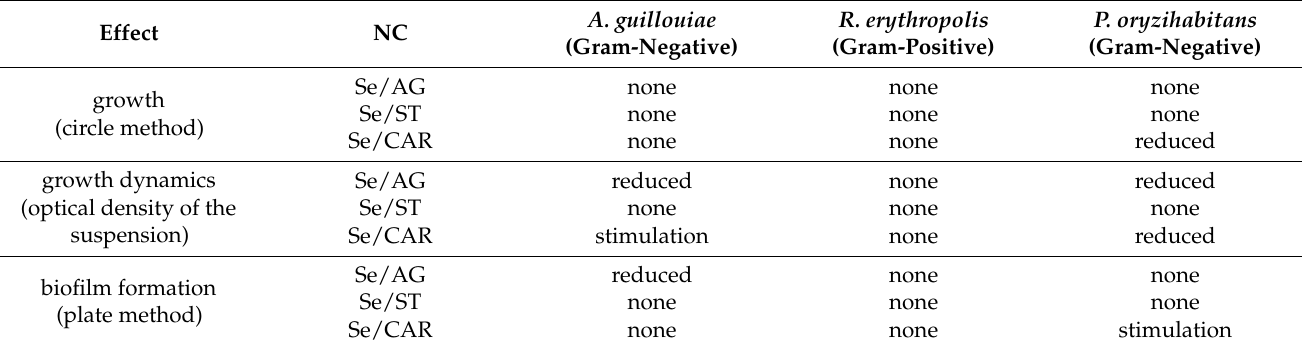
Table 2. Summary data on the antibacterial effect of Se NCs on rhizosphere bacteria in the study.